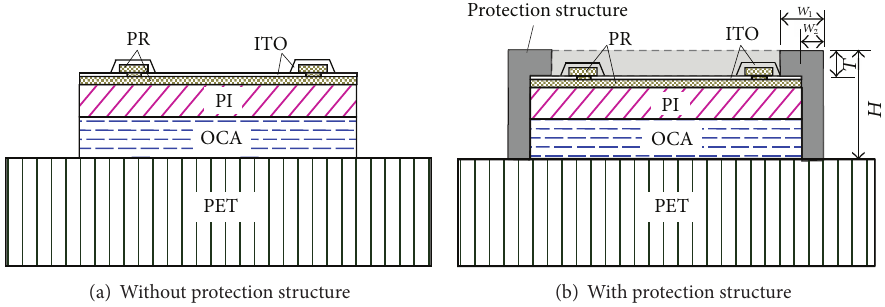
Figure 2: The TDP structure with or without a protection